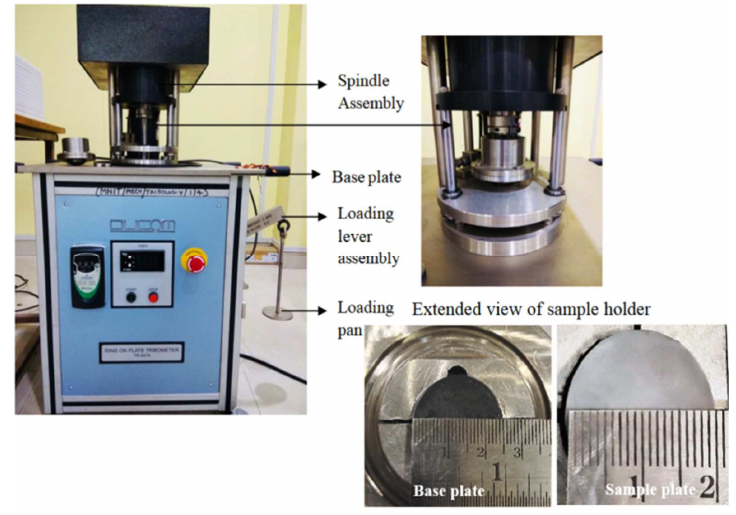
Figure 2. Ring on plate tribometer.